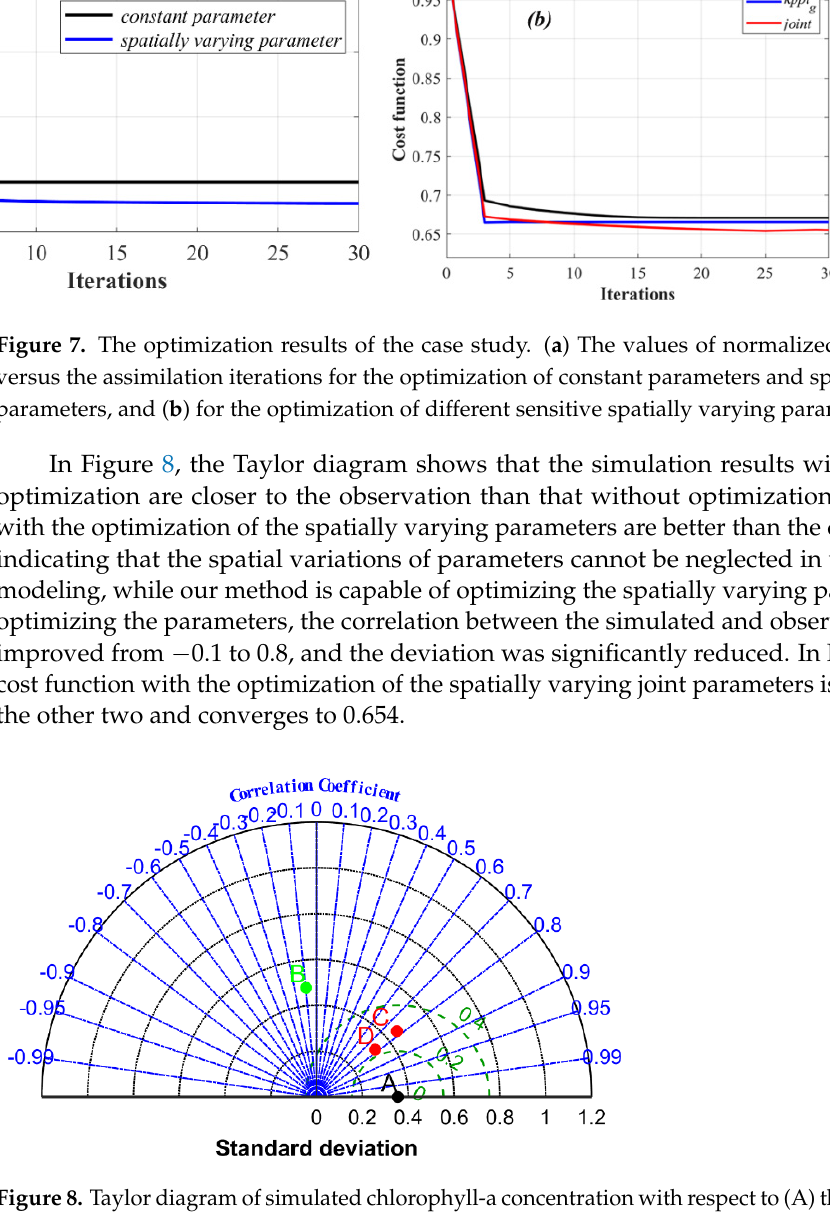
12 of 19 Figure 6. GSA results of different parameters and their impact on different state variables. P, Z, NH 4 , NO 3 , DON, D, PO 4 , DOP, and DO represent phytoplankton, zooplankton, ammonium, nitrate, dis- solved organic nitrogen, detritus, phosphate, dissolved organic phosphorus, and dissolved oxygen, respectively. 3.3. Parameter Optimization Since most of the state variables were sensitive to k PPT_G and I opt , we mainly optimized these two parameters. In the actual simulation, the spatial patterns of the parameters were unknown. Generally, all the parameters were set as the constant values listed in Appendix A. During the optimization, we treated the parameters as constant or spatially varying.